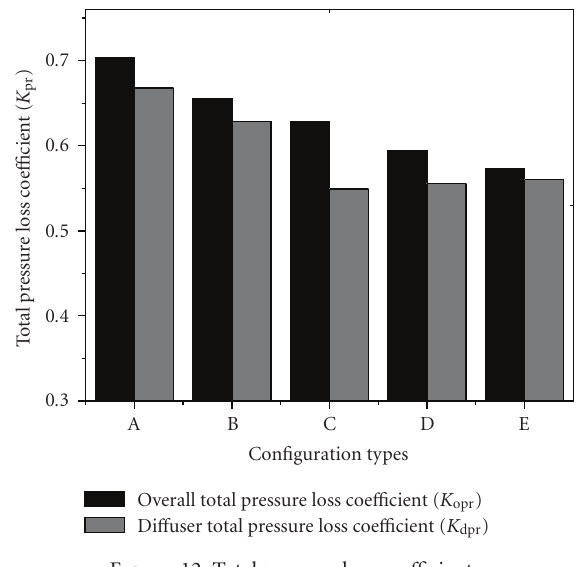
Figure 12: Total pressure loss coe ffi cient.